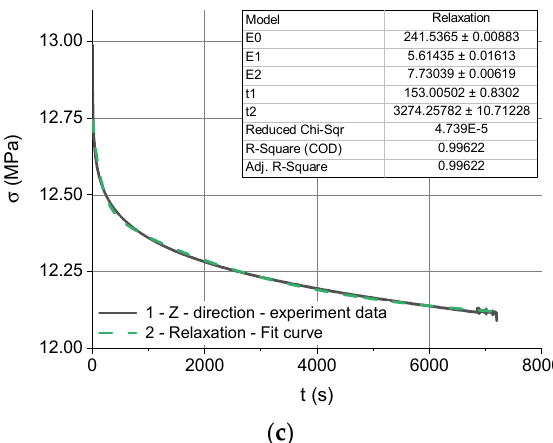
Figure 7. The results of the stress relaxation tests and the best fit curves: 1—experimental stress relaxation curves, 2—stress relaxation curves approximated by Equation (15): ( a ) for the specimens built in the X direction, ( b ) for the specimens built in the Y direction, ( c ) for the specimens built in the Z direction.